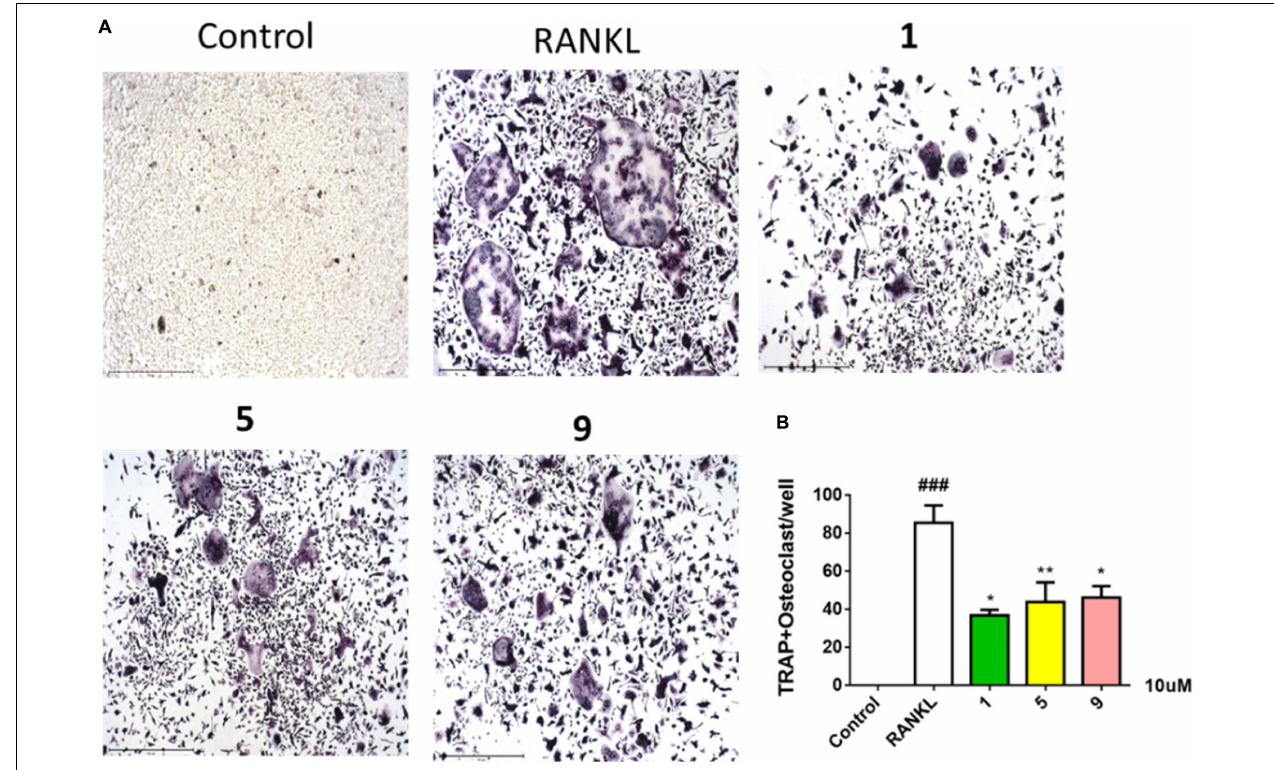
FIGURE 5 | Compounds 1 , 5 , and 9 suppressed RANKL-induced osteoclast differentiation. Representative images of osteoclasts from BMMCs treated with 1 , 5 , and 9 (10 µ M) for 3 days, tartrate-resistant acidic phosphatase (TRAP)–positive multinucleated cells were regarded as osteoclasts (A) and quantified (B) . All experiments were performed at least three times. The data are presented as the mean ± SD of representative experiments. ### p < 0.001 vs. control group; * p < 0.05 and ** p < 0.01 vs. RANKL